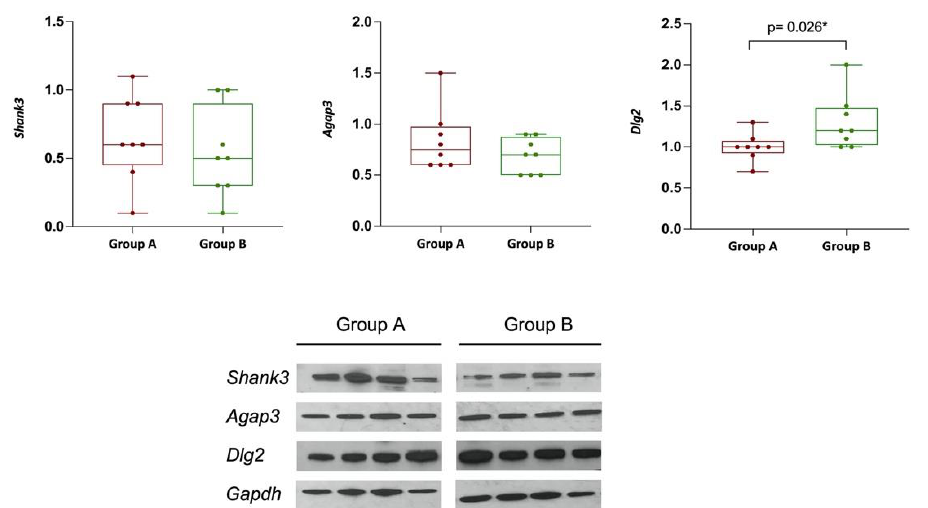
Figure 4. ( Top ): Boxplot charts showing the differential expression levels of SHANK3, AGAP3, and DLG2 in the two groups of mice. The comparison of expression levels of both SHANK3 and AGAP3, although in the right direction relative to the methylation data, did not reach statistical significance. A significant increased expression of DLG2 was observed in Group B compared to Group A. ( Bottom ): Western blot of representative brain samples from Groups A and B ( n = 4) for all three proteins. GADPH was used as a loading control. * Denotes statistical significance ( p -value < 0.05).